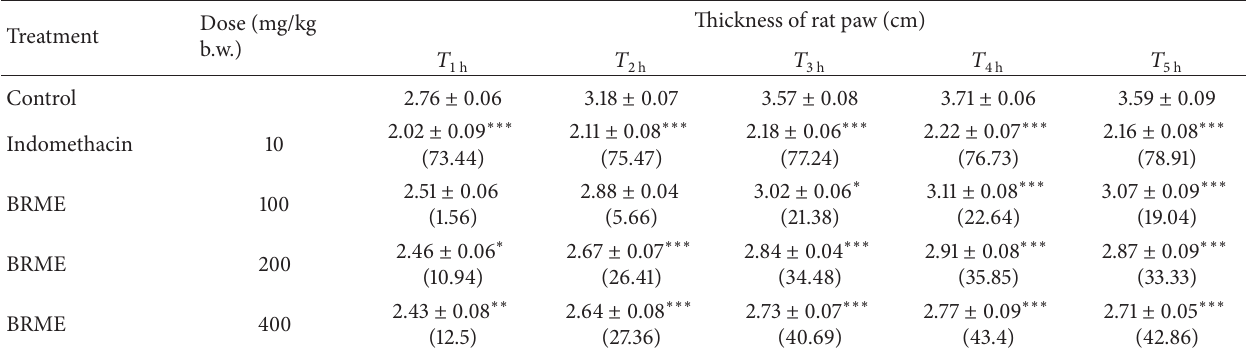
Table 4: Effect of methanolic extract of fruit of Bridelia retusa on arachidonic acid-induced paw oedema. Dose (mg/kg Treatment b.w.)